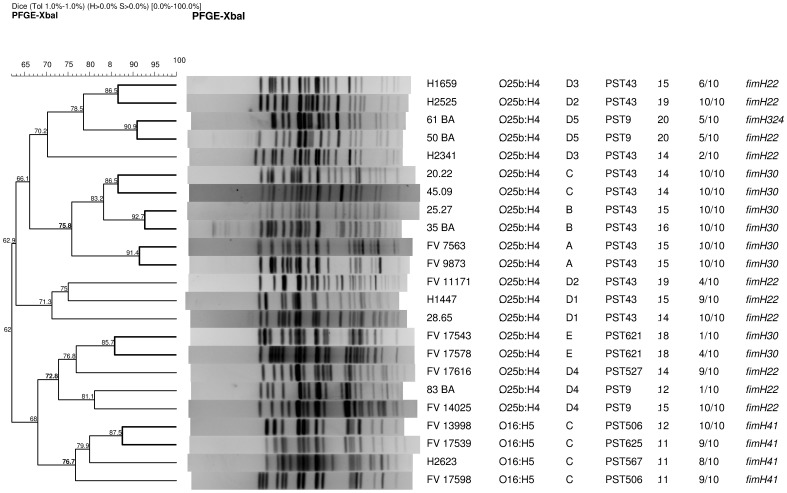
Pulsed-field gel electrophoresis of XbaI-digested DNA from 23 ST131 E. coli isolates.The dendrogram was obtained with the UPGMA algorithm based on the Dice similarity coefficient and applying 1% of tolerance in the band position. Isolate designation, O:H serotype, virotype, PST, virulence-gene score, final lethality (mice dead within 7 days/mice challenged), and fimH subtype are shown on the right.